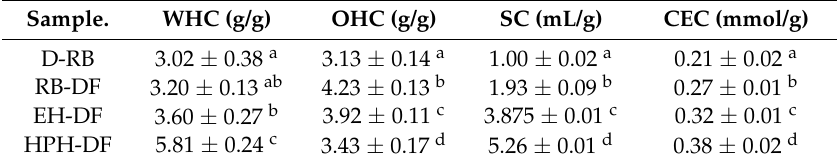
Data were expressed by means ± standard deviation (SD). Values in the same column with different letters are significantly different ( p < 0.05). CEC cation-exchange capacity, D-RB defatted rice bran, EH-DF cellulase